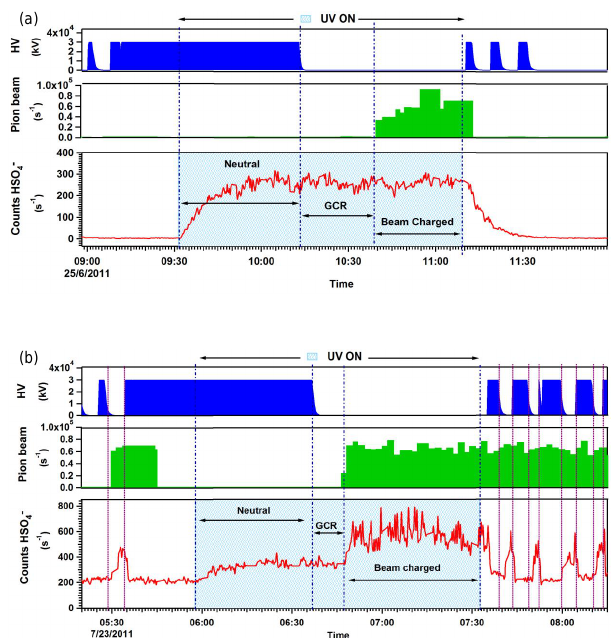
Figure 1. (a) Measurement of the CIMS bisulfate ion signal Fig. 1. a) Measurement of the CIMS bisulphate ion signal (HSO 4– , red trace) during a typical 7 (HSO − , red trace) during a typical binary nucleation experiment, 4 binary nucleation experiment, displayed along with the variation of pion beam intensity (green) 8 displayed along with the variation of the pion beam intensity (green) and clearing field high voltage (blue). b) Measurement of the CIMS bisulphate ion signal for the 9 and the clearing field high voltage (blue). (b) Measurement of the ternary system (involving pinanediol) under the same beam condition as in a) (red vertical lines 10 CIMS bisulfate ion signal for the ternary system (involving pinane- diol) under the same beam conditions as in (a) (magenta vertical lines show the ion effect under no-UV conditions). The CIMS sig- nal is influenced by additional HSO − ions from the chamber. This 4 ion effect leads to an overestimation of the sulfuric acid concentra-